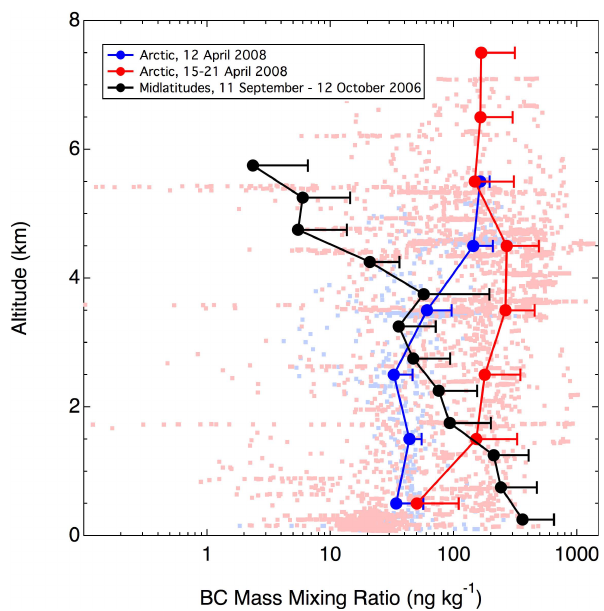
Fig. 2. Vertical profiles of BC mass mixing ratio for 5 flights in the Arctic during ARCPAC and 16 flights at midlatitudes in east- ern Texas during the Texas Air Quality Study. The data in blue and red are from 1 flight in the aged Arctic air mass and 4 flights in long-range biomass-burning plumes, respectively. The small dots and line markers denote 30s averages and 1km mean values, re- spectively, of BC mass mixing ratio, except for the midlatitude data where 0.5km averages are shown without the underlying 30s data. The horizontal bars represent one standard deviation on both sides of the mean but are only drawn on the positive side for visual